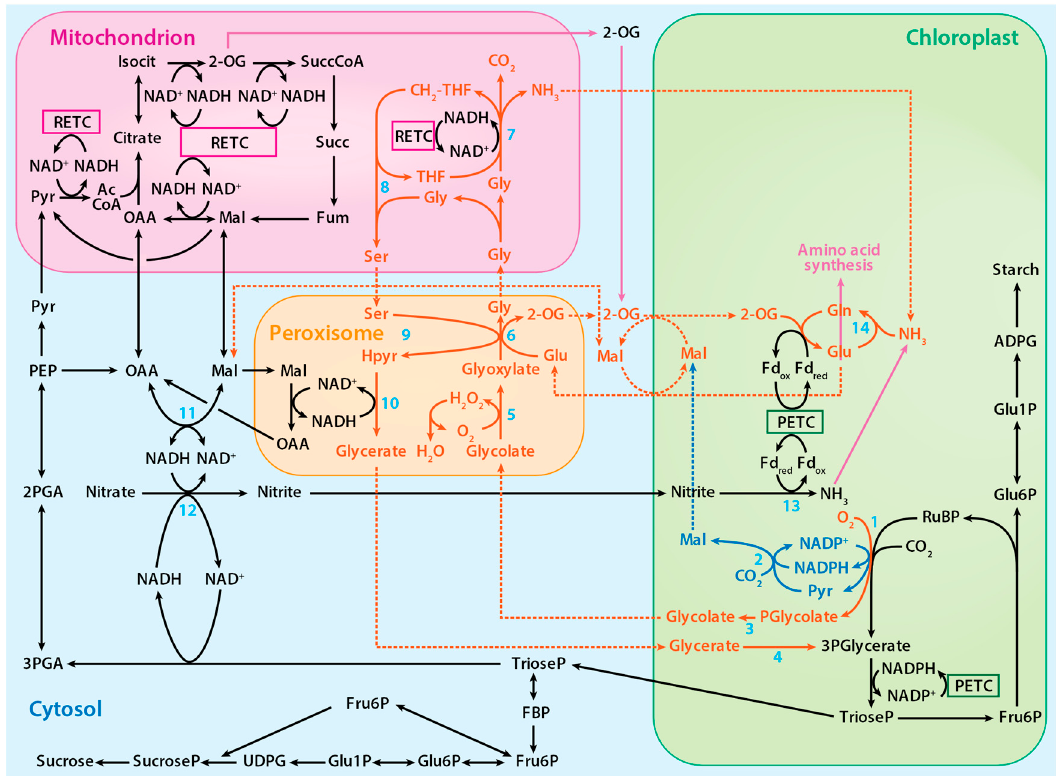
Figure 2. The proposed photorespiratory pathway within the context of photosynthetic carbon and nitrogen metabolism. The solid red lines represent reactions of the photorespiratory pathway, the solid blue lines represent reactions of the proposed alternative photorespiratory pathway, the solid purple lines represent reactions of amino acid synthesis, and the dotted lines represent associated transport processes. Numbered reactions are catalyzed by the following enzymes: 1. Rubisco, 2. Malic enzyme, 3. Phosphoglycolate phosphatase, 4. Glycerate kinase, 5. Glycolate oxidase, 6. Glutamate:glyoxylate aminotransferase, 7. Glycine decarboxylase complex, 8. Serine hydroxymethyltransferase-1, 9. Serine:glyoxylate aminotransferase, 10. Hydroxypyruvate reductase-1, 11. Malate dehydrogenase, 12, Nitrate reductase, 13 Nitrite reductase, and 14. Glutamine synthetase. PETC designates photosynthetic electron transport chain and RETC, respiratory electron transport chain. Adapted from ref. [8]. Copyright 2018 Springer Nature